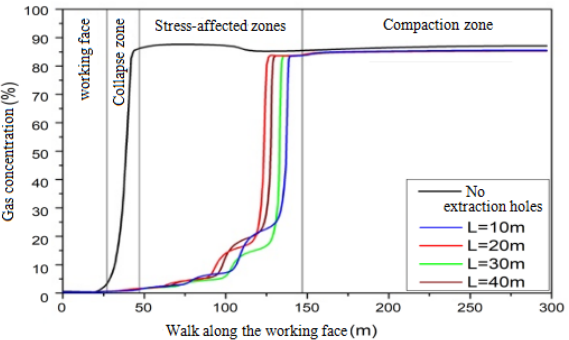
Figure 7. Distribution of methane concentration along the center line of the return airway at different distances between the borehole and the upper corner.